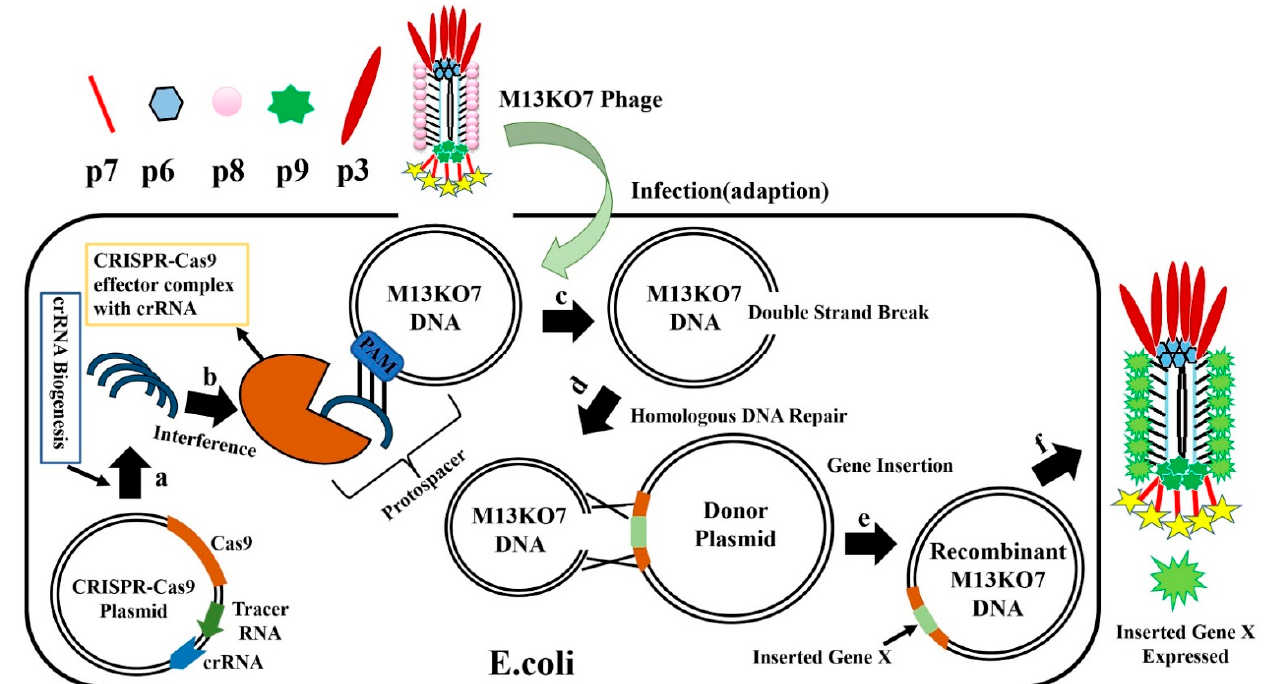
Figure 10. Overview of M13KO7 phage genome editing by CRISPR-Cas9. ( a ) The CRISPR-Cas9 plasmid synthesizes crRNA and CAS9 protein in E. coli , and forms the effector CAS9-crRNA complex; ( b ) E. coli carrying the CRISPR-Cas9-SgrNA plasmid is infected with phage M13KO7, and the CAS9-CrRNA complex binds to Phage M13KO7 DNA containing PAM sites; ( c ) Cas9-crRNA complex forms a double-strand break inM13KO7 phage DNA; ( d ) using homologous DNA repair, the donor plasmid carrying the novel gene repairs the broken M13KO7 phage DNA; ( e ) gene repair generates the recombinant M13KO7 phage-carrying gene X. ( f ) After trans- lation and packaging, the recombinant M13KO7 phages-expressing gene X is secreted from E. coli .